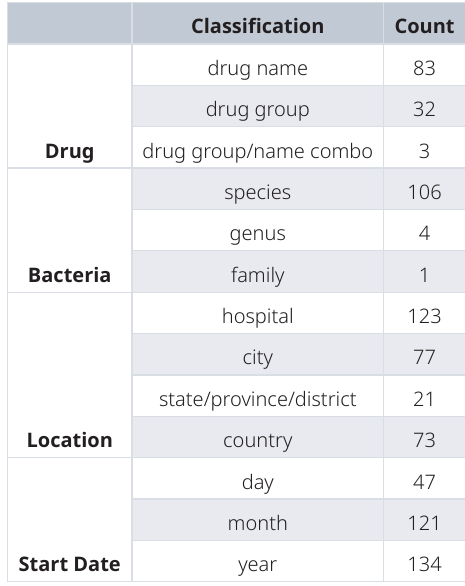
Table 2. Classification specificity of four primary database